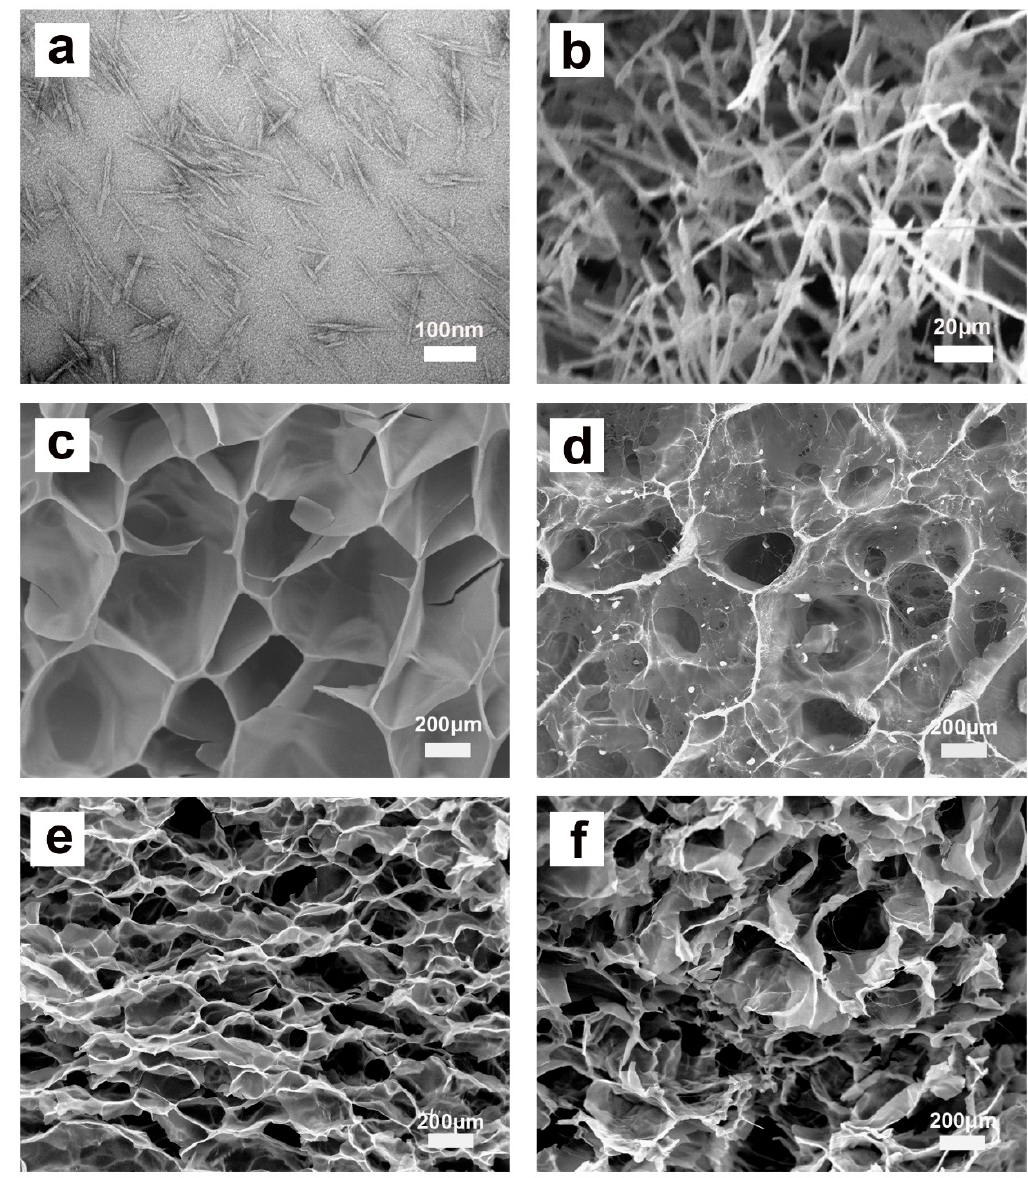
Figure 3. TEM image of CNCs ( a ) and SEM images of CNC aerogel ( b ), P(AA / AM) ( c ), CNC-g-P(AA / AM)-0.5 ( d ), CNC-g-P(AA / AM)-1 ( e ), and CNC-g-P(AA / AM)-2 ( f ).